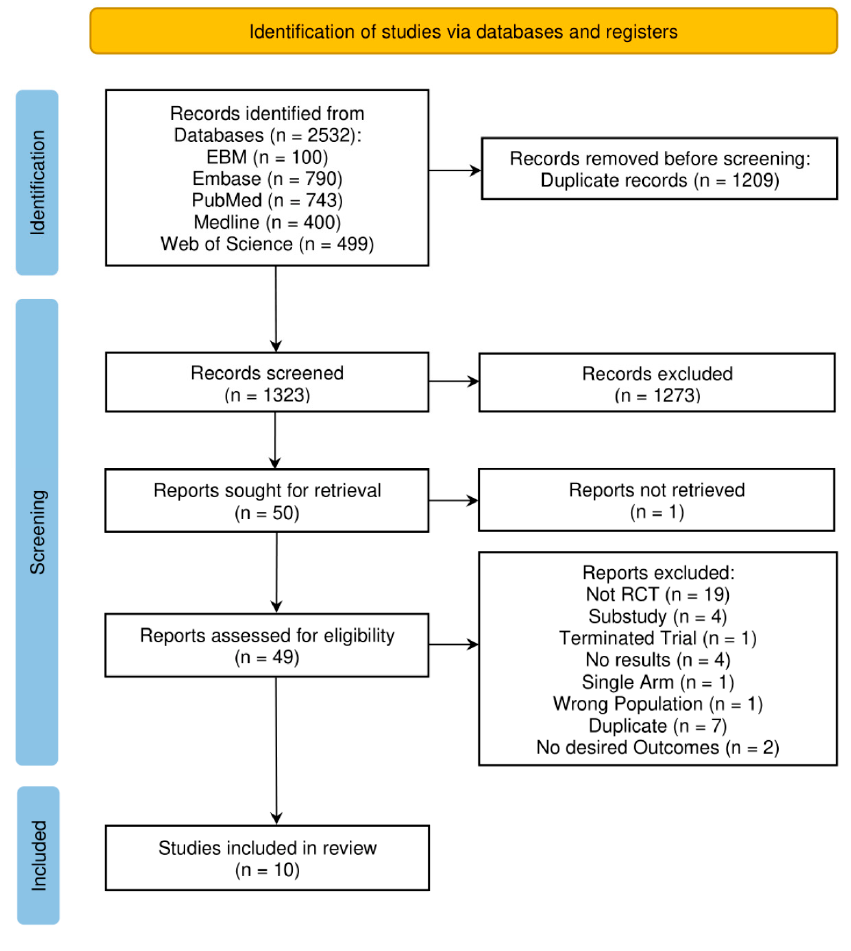
Figure 1. PRISMA flow chart representing the literature screening process [15] .